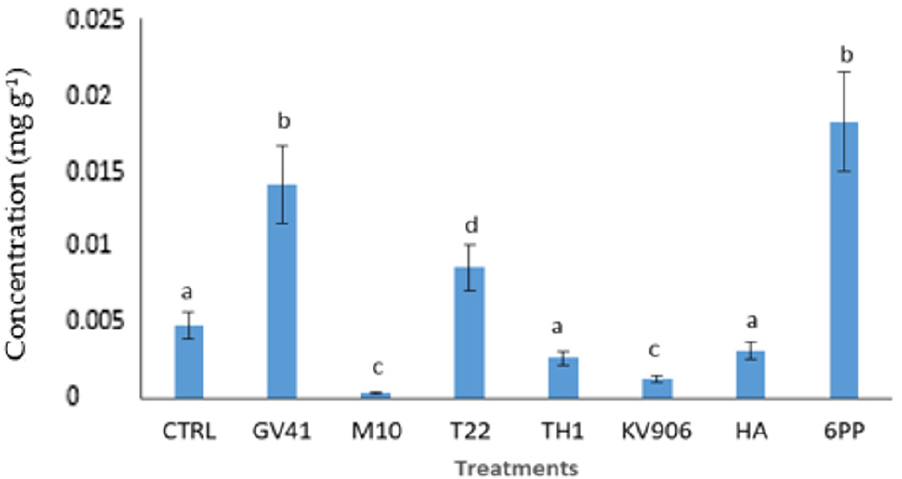
Figure 3. Oleuropein content in drupes. Samples are indicated by treatments with Trichoderma strains (TH1, GV41, T22, M10, and KV906) or secondary metabolites (HA and 6PP). Values are the means of three replicates ± SE. Different letters indicate significant differences ( p < 0.05).